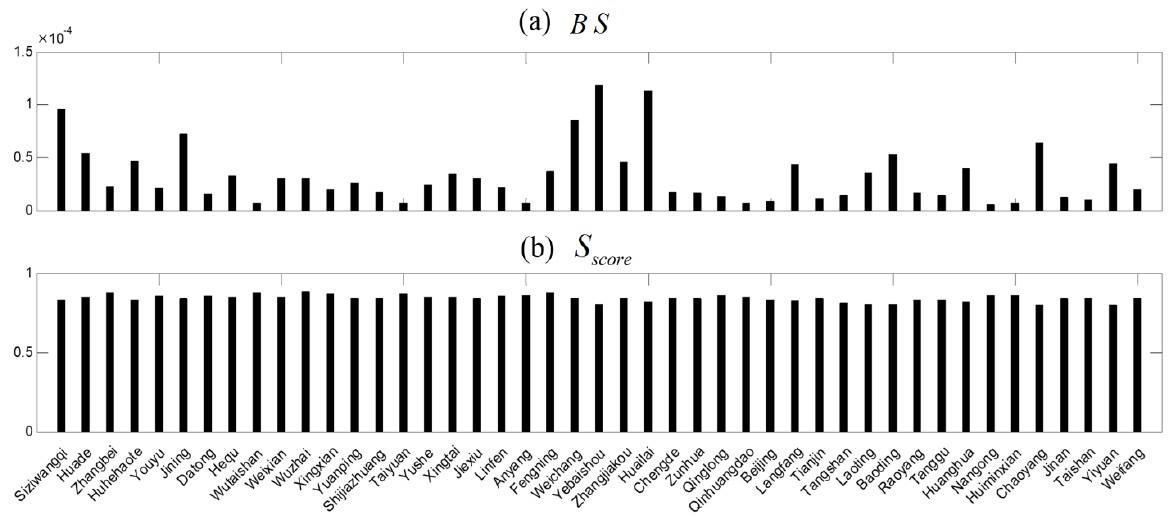
Figure 13. Quantitative evaluation of the summer precipitation downscaling probability density function pdf simulation results for each station in North China: ( a ) Histogram of BS indicators for each station, ( b ) histogram of S score indicators for each station.